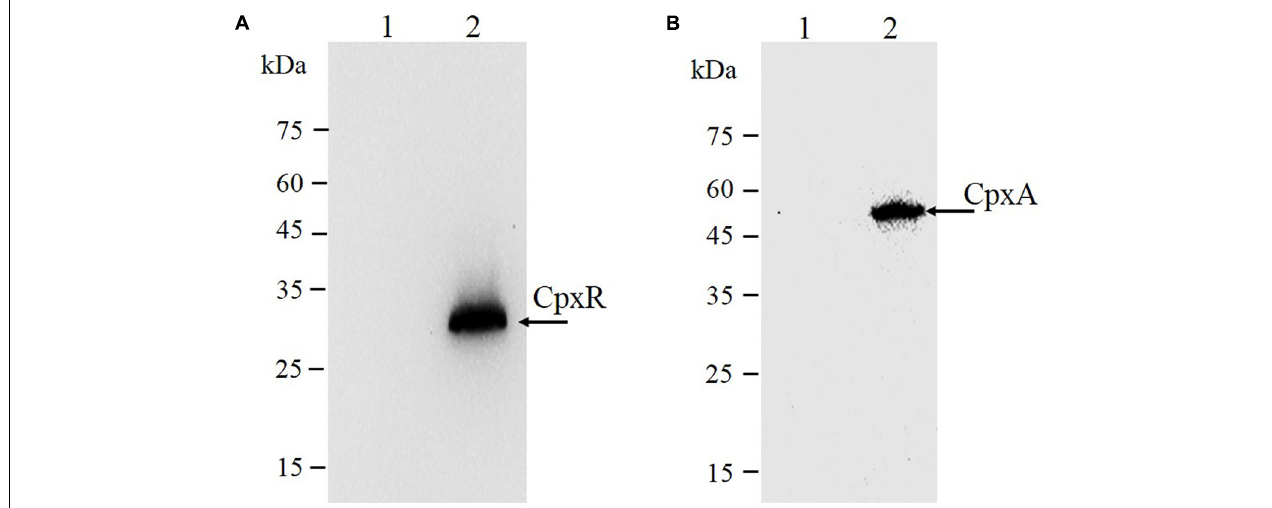
FIGURE 4 | Immunodetection of 3 × FLAG epitope-tagged protein. Tagged bacterial lysates were subjected to electrophoretic separation in a 12% SDS-PAGE gel and then transferred to polyvinylidene fluoride (PVDF) membranes and probed with anti-FLAG M2 mAbs (Sigma). (A) CpxR protein: 1, strain JS (parent strain); 2, strain JS CpxR N − 3 × FLAG . The expected molecular mass of 3 × FLAG-CpxR is 28.99 kDa. (B) CpxA protein: 1, strain JS (parent strain); 2, strain JS CpxA C − 3 × FLAG . The expected molecular mass of CpxA-3 × FLAG is 54.32 kDa. On the left are protein marker positions and molecular length